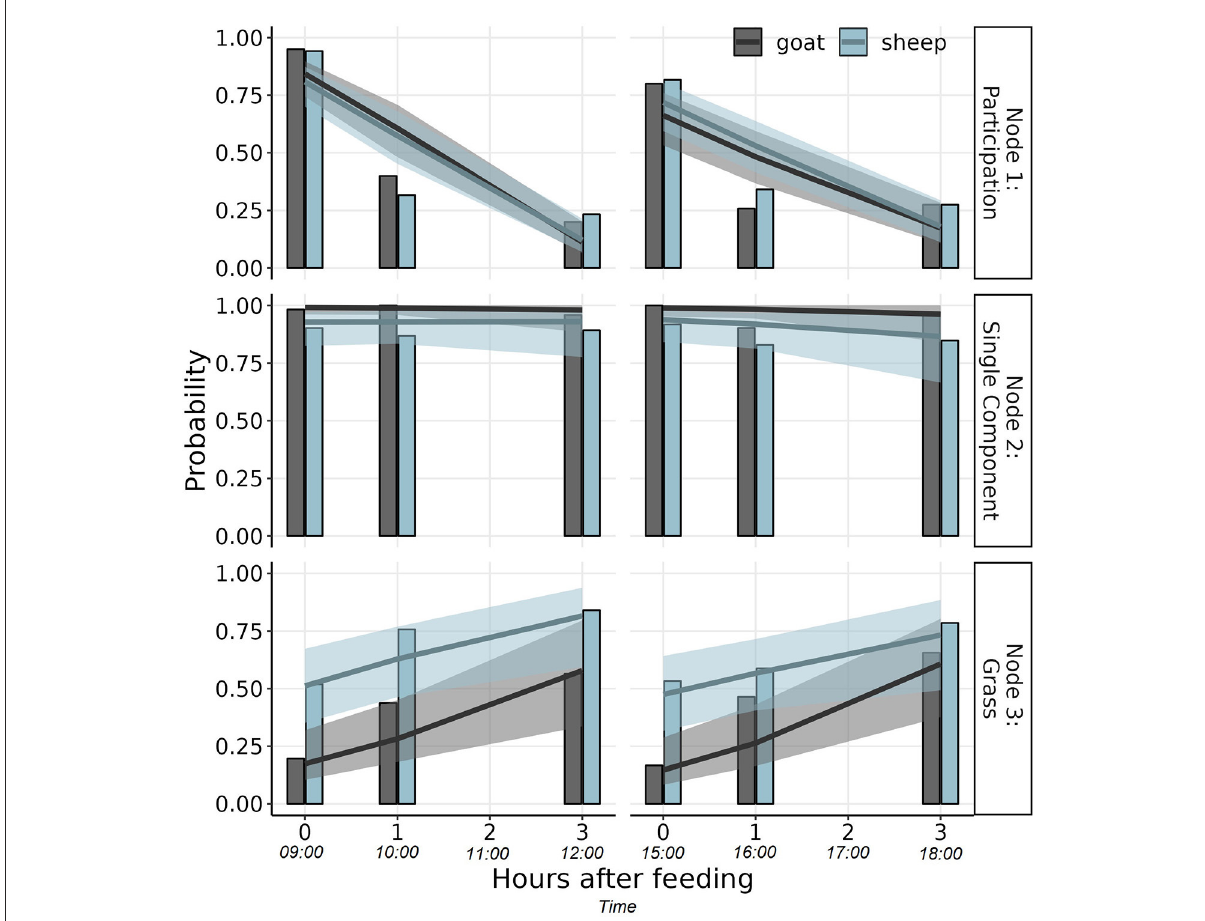
FIGURE5 Probability that an animal would choose a feed (i.e., participate) within the first minute after gaining access to the trough (node 1), that the animal would choose a single component (hay or grass silage) over the mixed ration (node 2), and that it would choose grass silage over hay (node 3) at six time points for goats (black) and sheep (blue). Solid lines represent population-level (i.e., described by fixed effects), means with 95% confidence bands as estimated using the IRTree GLMM (shaded